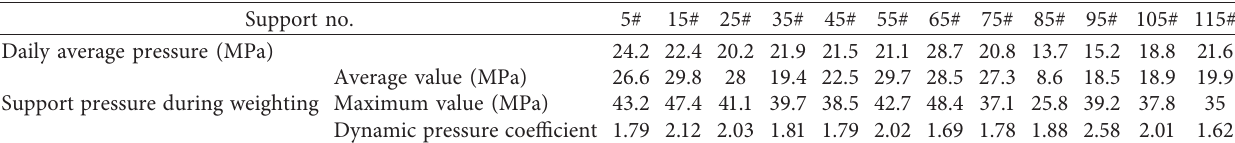
Figure 10: Variation curve of typical support pressure monitored in June 2014 [24]. (a) Support 5#. (b) Support 15#. (c) Support 25#. (d) Support 55#. (e) Support 75#. (f) Support 115#. Table 2: Support pressure of panel 1061